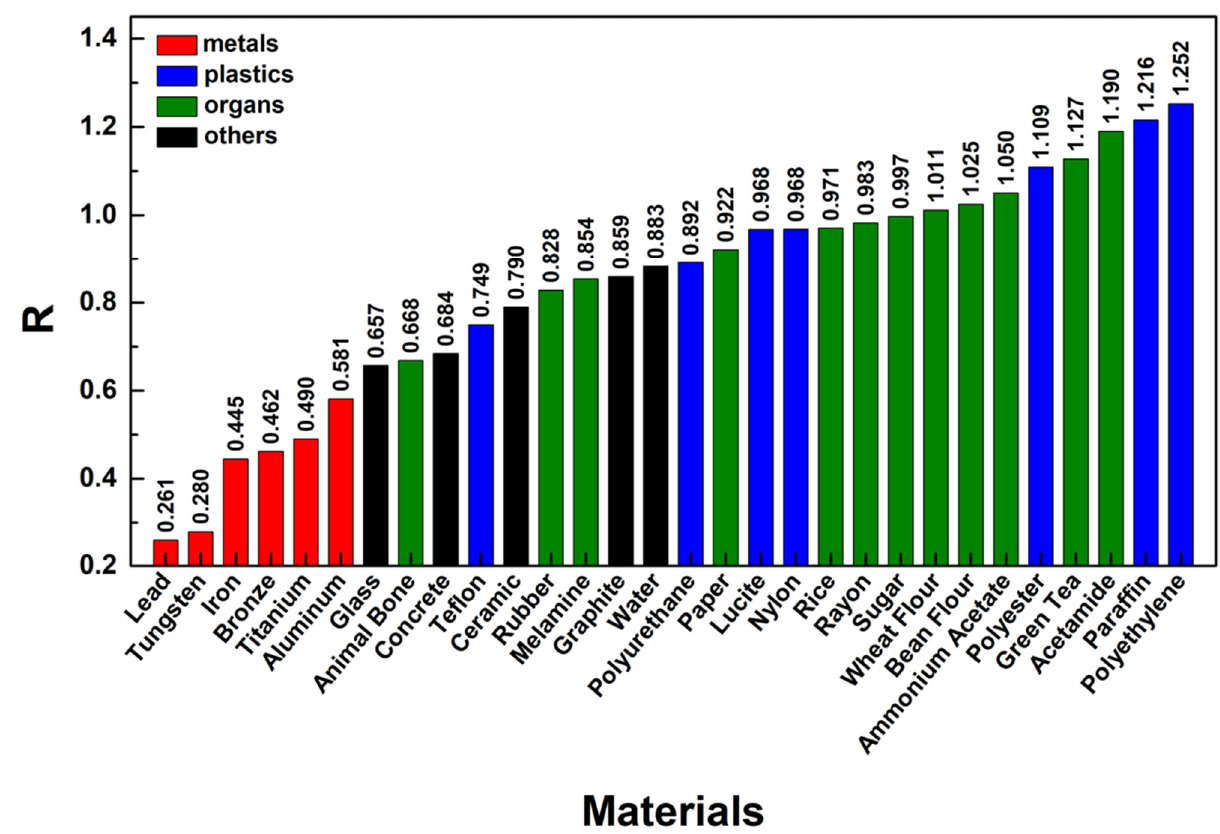
Figure 8. R-values of material samples.